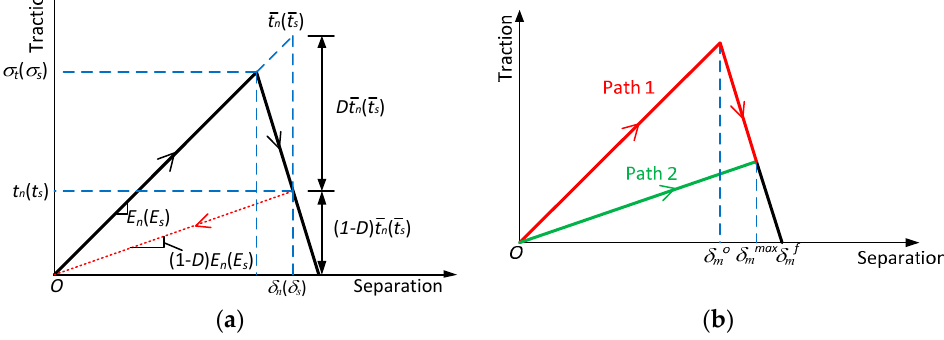
Figure 6. The relationship between traction and separation. ( a ) Tensile and shear components; ( b ) resultant traction. In ( a ), E n and E s are the initial tensile stiffness and shear stiffness of CPPE, Pa/m; δ n and δ s are tensile and shear separation components, respectively. ( a ) interprets the concept of D , and ( b ) illustrates the concept of loading history (path 1 or path